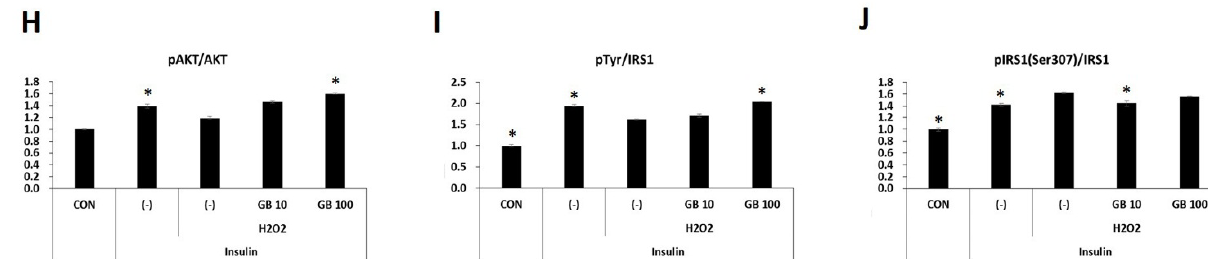
Figure 5. Ginseng berry (GB) extract supplementation increases protein kinase B (AKT) and insulin receptor substrate-1 (IRS-1) in skeletal muscle of aged mice. ( A – E ) Fifteen-month-old mice were fed a regular diet (CON) or regular diet supplemented with 0.05% ginseng berry extract (GBD) for 6 months ( n = 8 in each group). Skeletal muscle tissue was collected 7 min after insulin injection (2 U kg −1 , i.p.). ( A ) Protein expression of AKT and